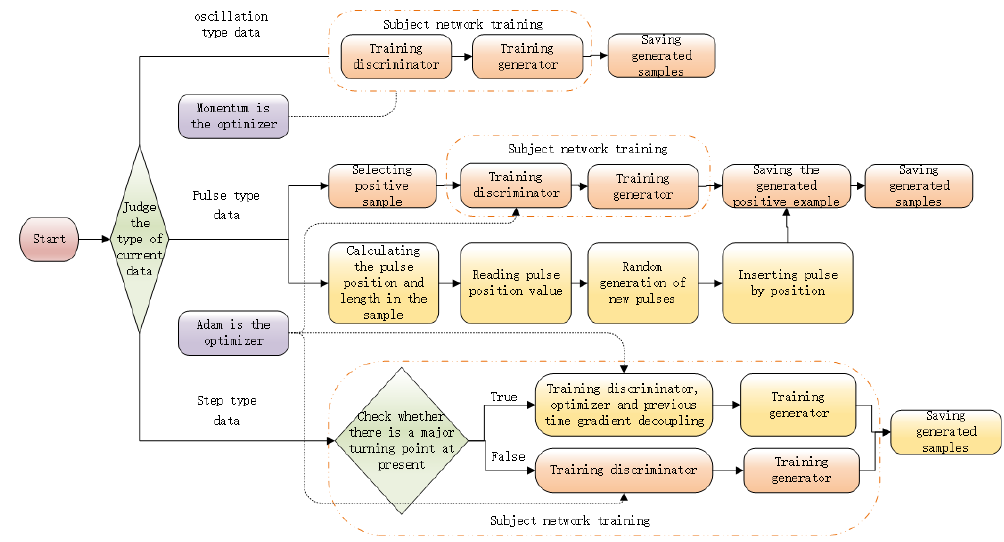
Figure 3. The overall flow chart of the